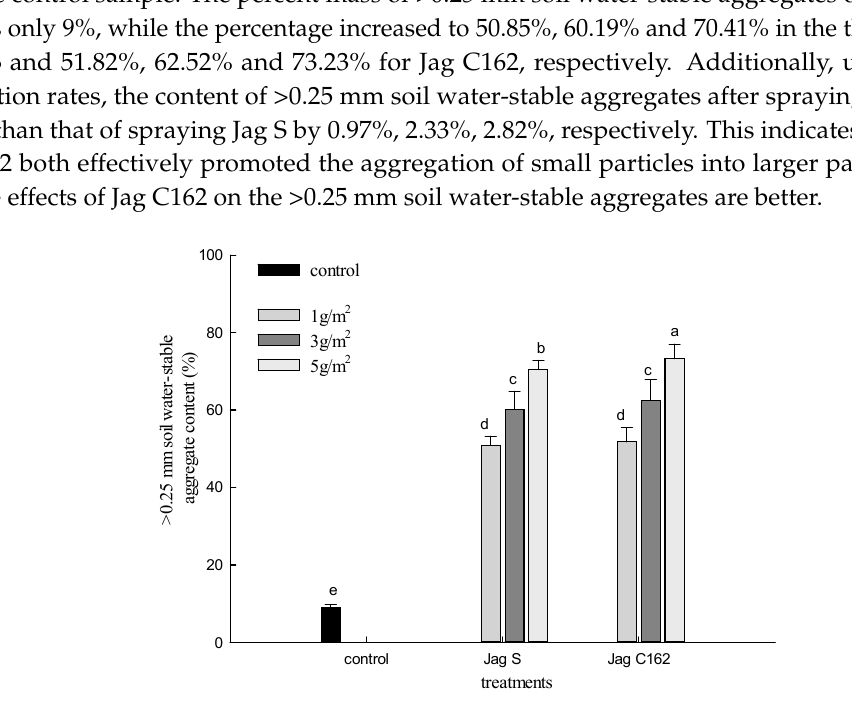
Figure 1. Effect of Jag S and Jag C162 on >0.25 mm soil water-stable aggregates. The letters “a”–“e” represent significant differences.